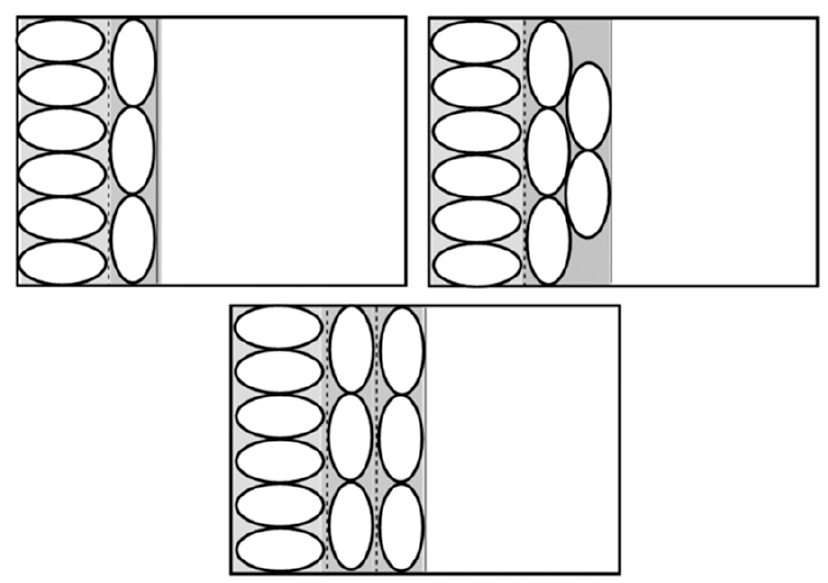
Figure 14. Examples of combinations of sections assuming each arrow a is parallel to Y-axis.